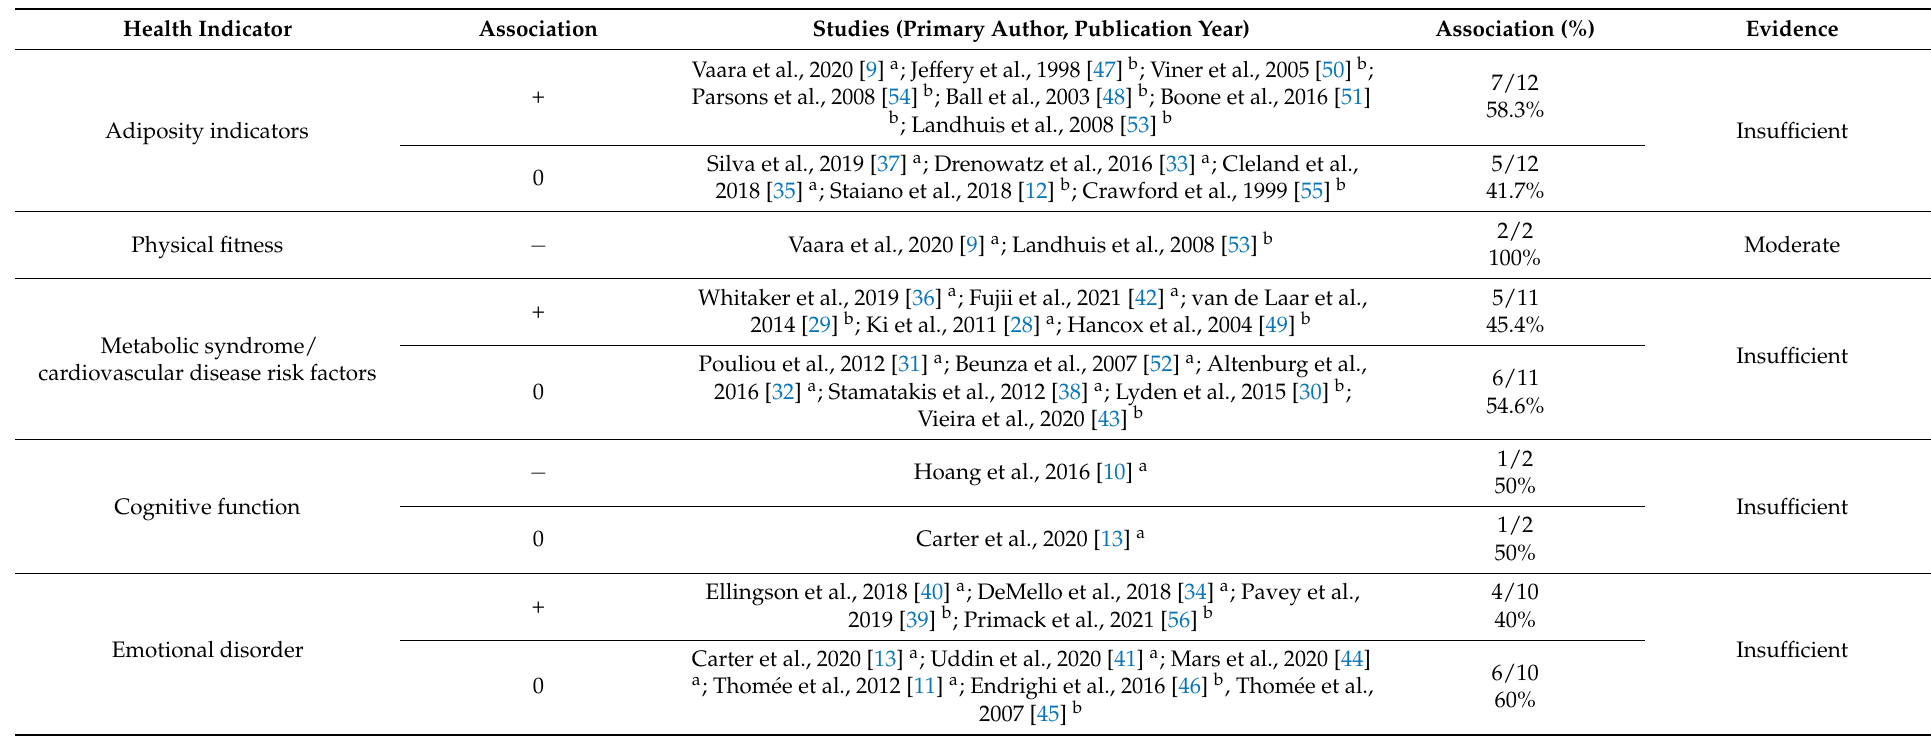
Table 3. The results of the data